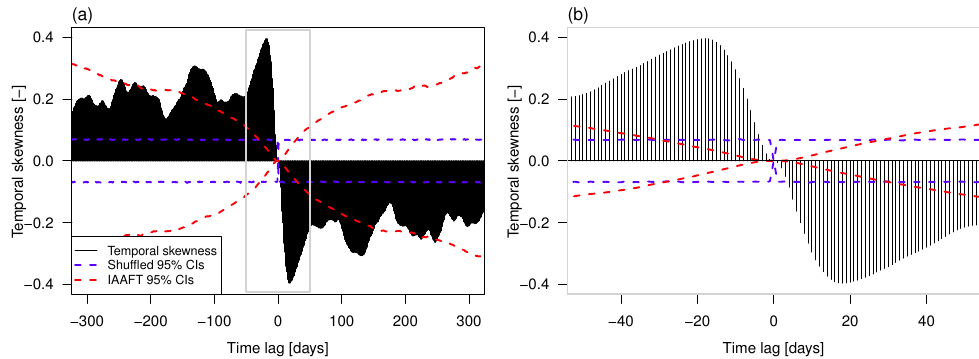
Figure 4. ( a ) Coefficient of temporal skewness of normalized and deseasonalized stream flow fluctuations for the Elbe River at Magdeburg-Strombruecke at several lags; ( b ) Magnification of the first 50